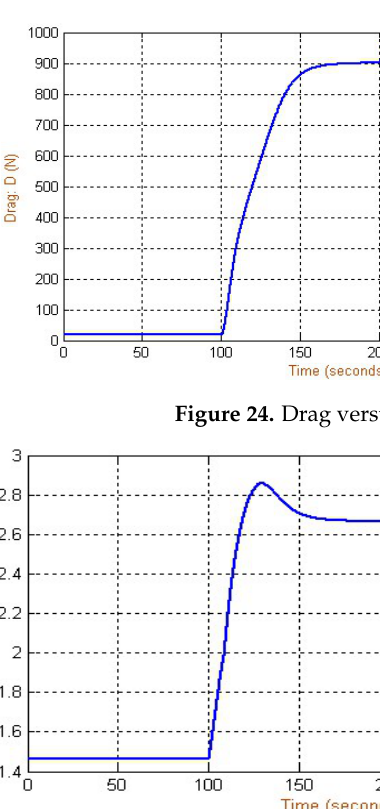
Figure 23. Speed versus time.